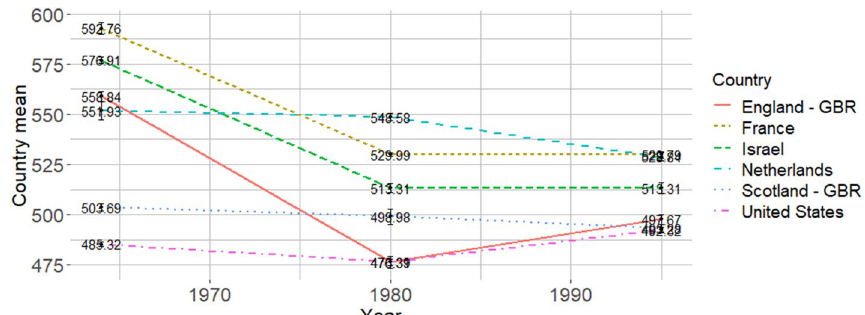
Fig. 2 Trends of grade 8 mathematics